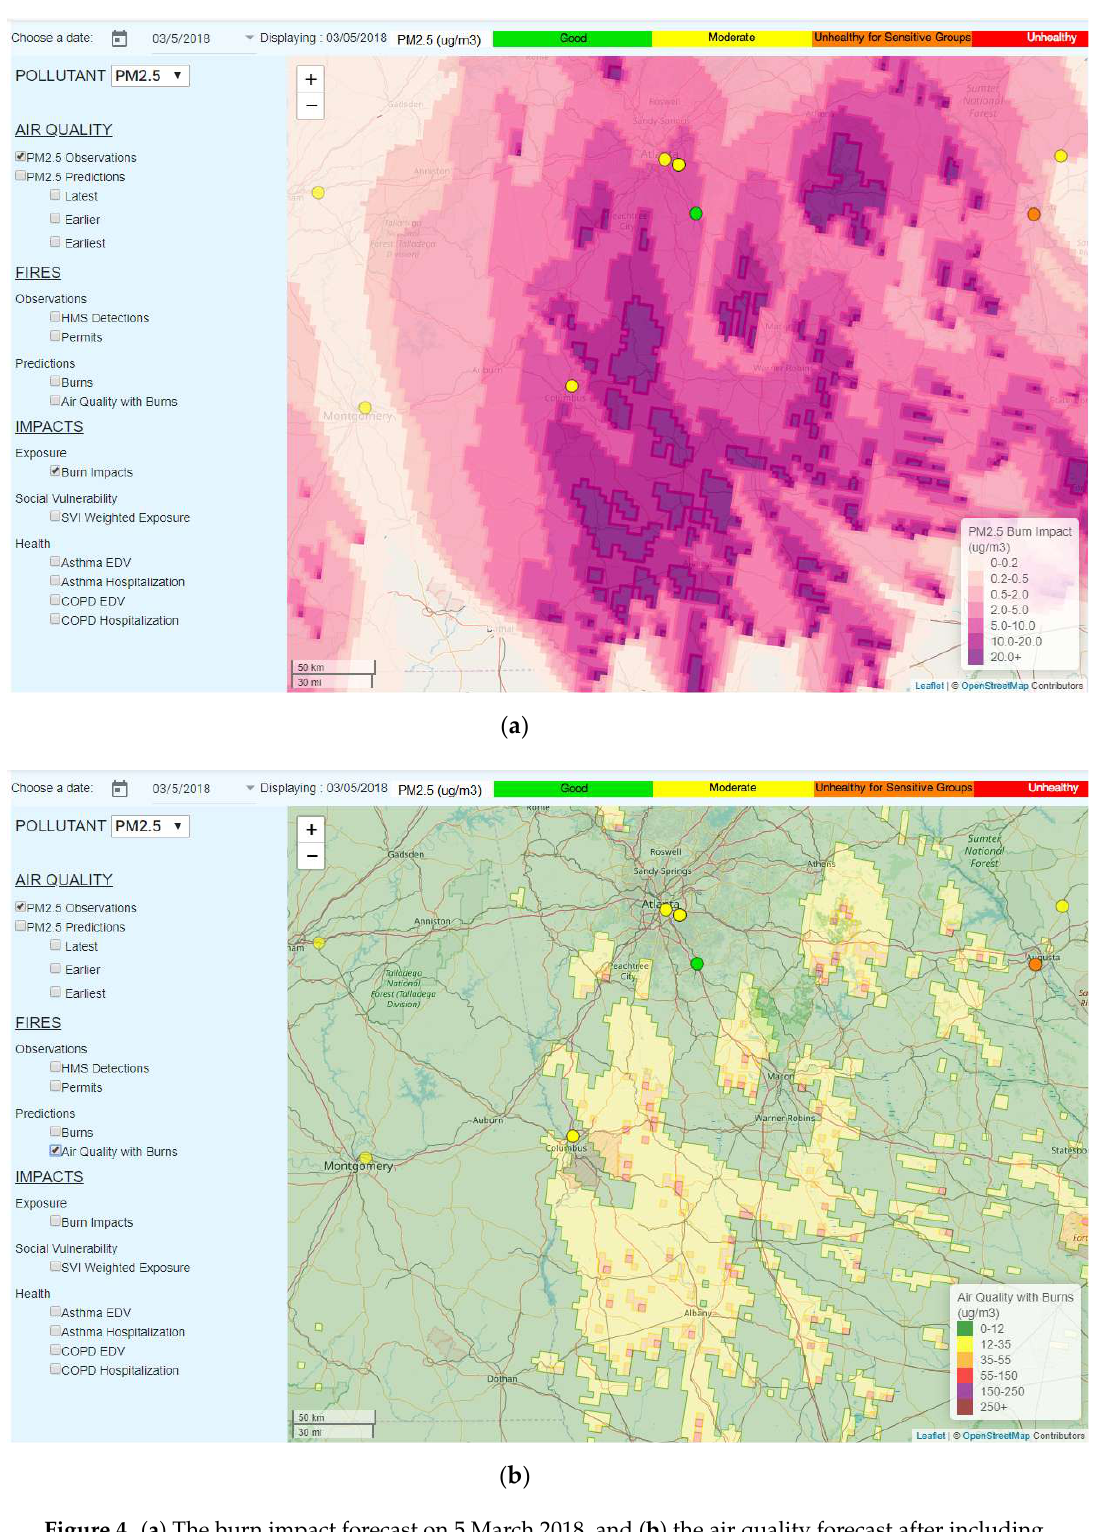
Figure 4. (a) The burn impact forecast on 5 March 2018, and ( b) the air quality forecast after including the impact of